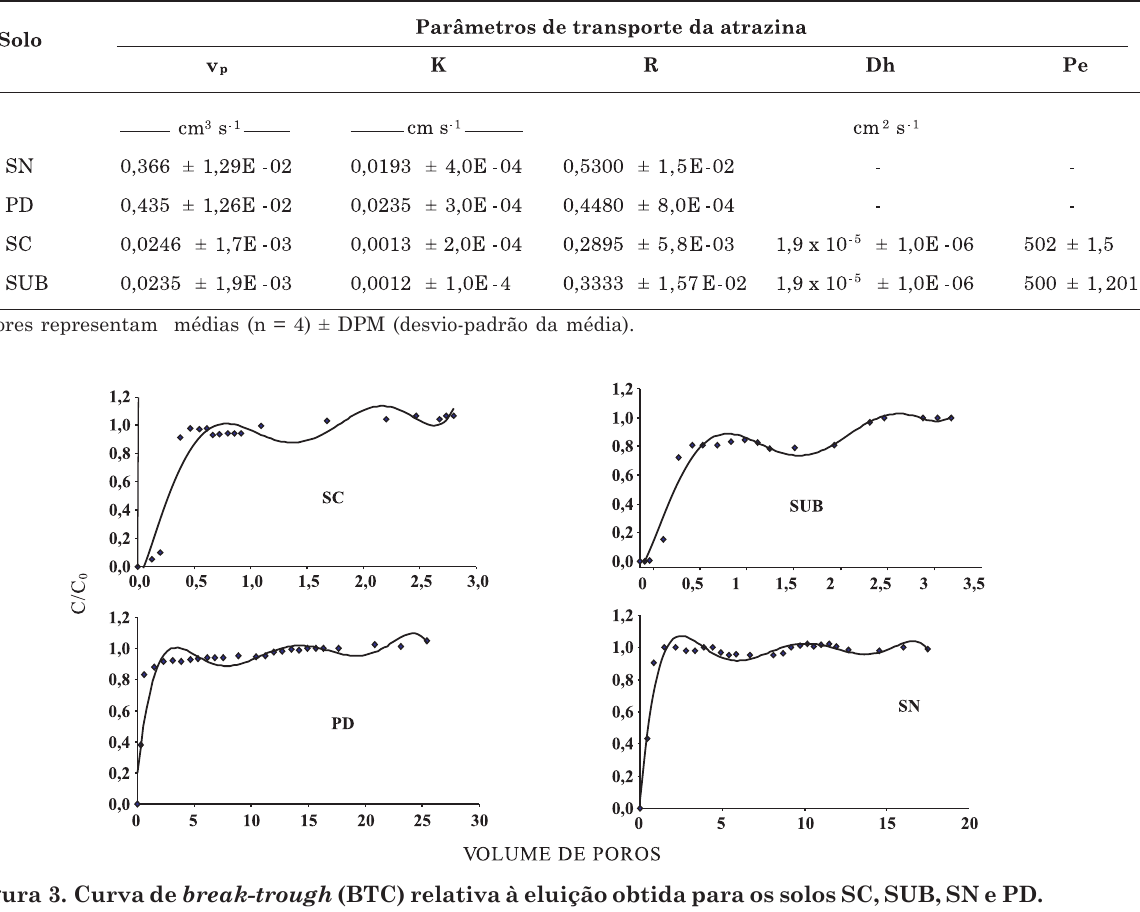
), condutividade hidráulica (K), p